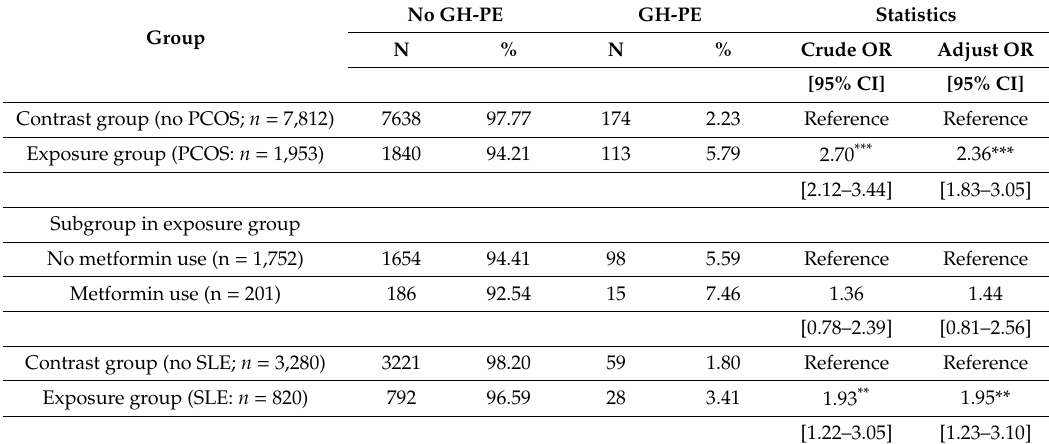
Table 3. Risk analyses of subsequent GH-PE in primiparas with prepregnancy PCOS and